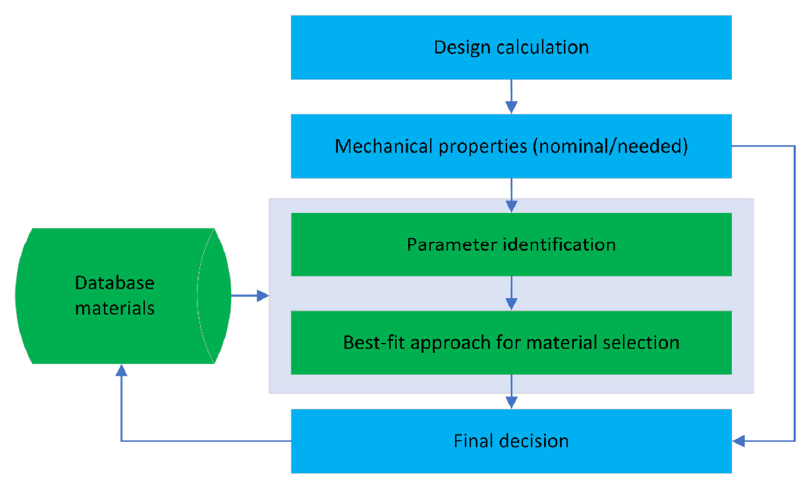
Figure 1. The scheme of the proposed methodology.